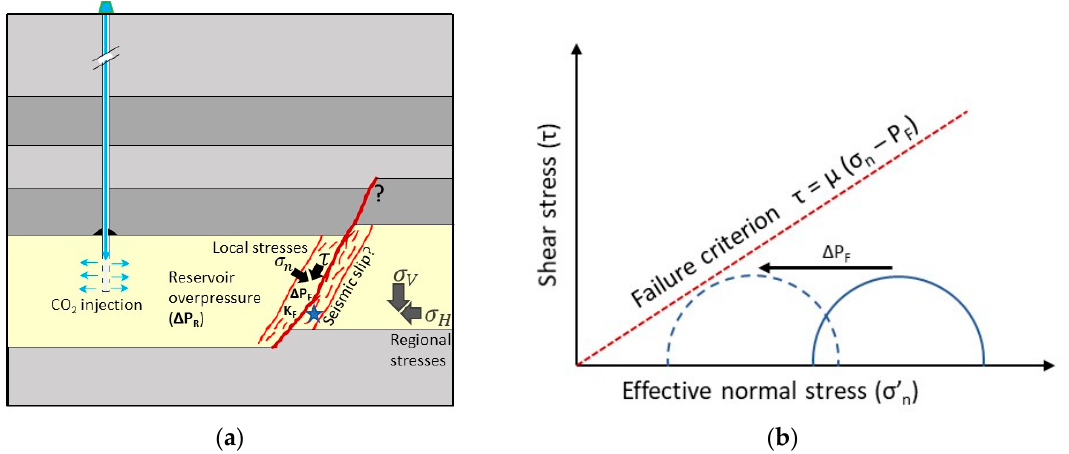
Figure 1. ( a ) Schematic presentation of CO 2 injection in a reservoir causing overpressure, ∆ P R , pore pressure inside a fault zone, ∆ P F , fault permeability, K F , and the local normal ( σ n ) and shear stresses ( τ ) in a fault zone. ( b ) A critical fluid pressure within a fault, ∆ P F -which may be di ff erent from the ∆ P R and can push a stable case (full circle) towards failure (dashed circle).